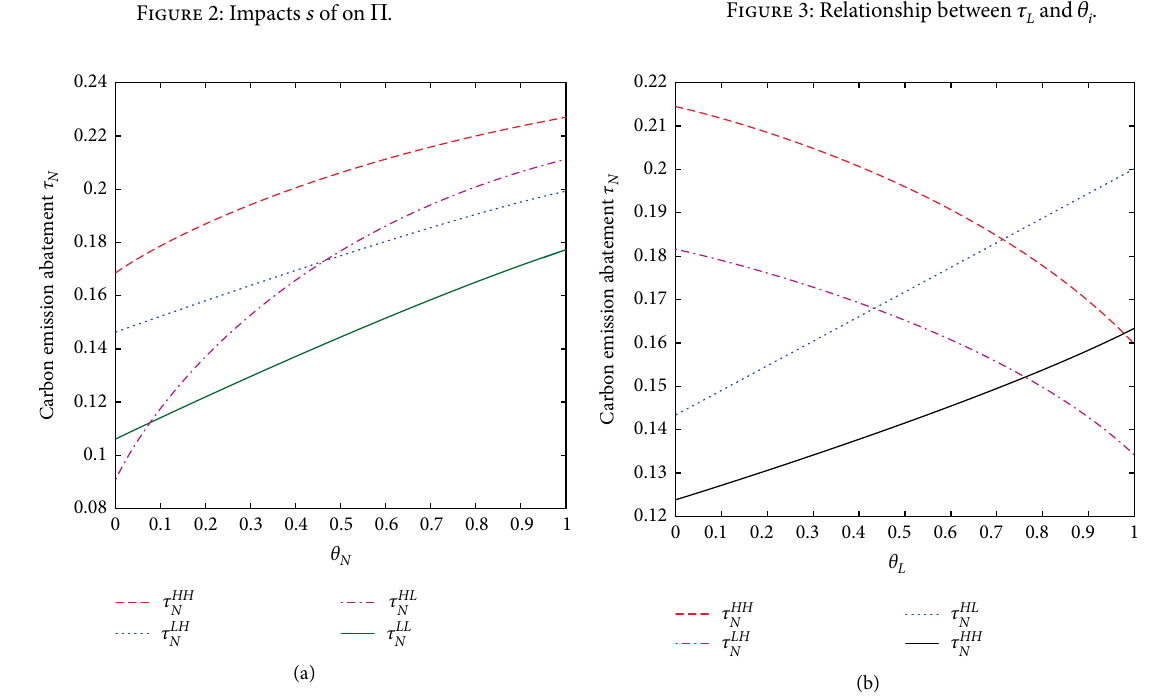
Figure 4: (a) Impact of 𝜃